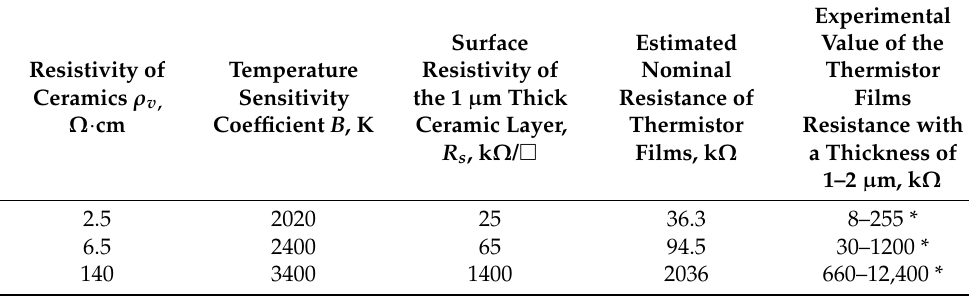
Table 2. Surface resistivity and nominal resistance of thermistor films, calculated for a thickness of 1 µ m, as well as experimental values of the thermistor film